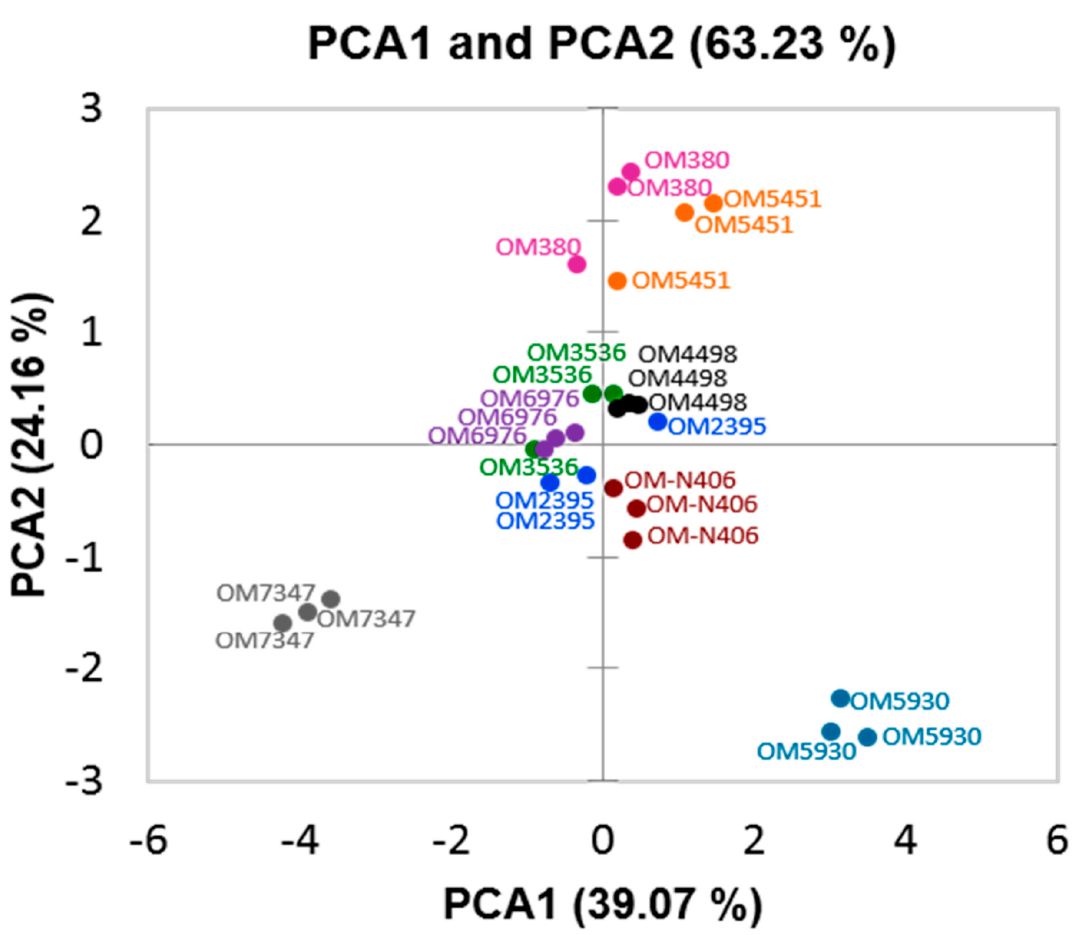
Figure 3. Principal component analysis of allelochemical data of the rice cultivars (OM2395, OM5451, OM6976, OM380, OM5930, OM4498, OM3536, OM-N406, and OM 7347).